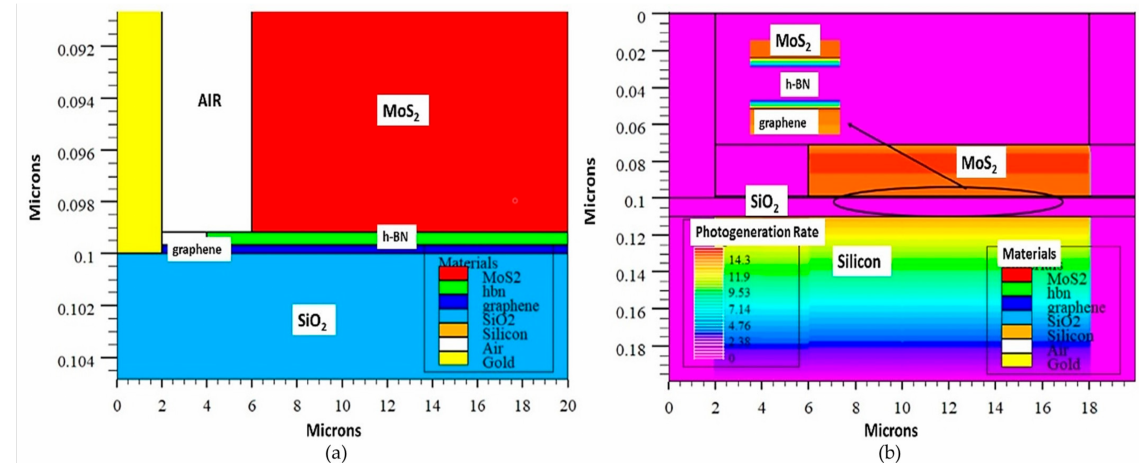
Figure 15. ( a ) Model of MoS 2 /h-BN/graphene photodetector. Adapted from [10] and ( b ) Photogeneration rate in MoS 2 /h- BN/graphene photodetector under illumination at 532 nm (© 2020 IEEE. Reprinted, with permission, from